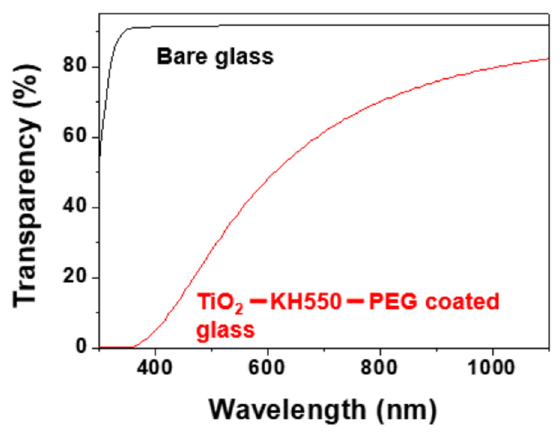
Figure 10. Transparency of bare glass and TiO 2 –KH550–PEG film on a glass substrate.